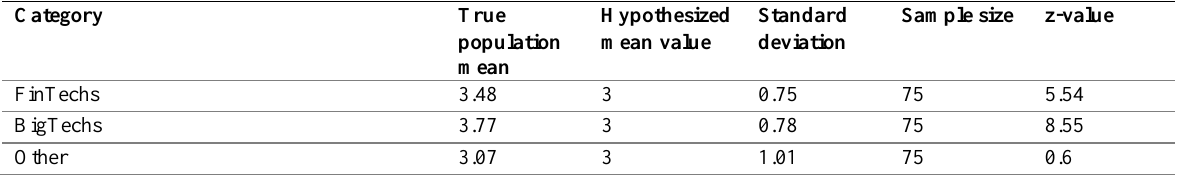
Table 3 : Analysis of z-test results to assess the impact on business models in the Swiss Banking industry